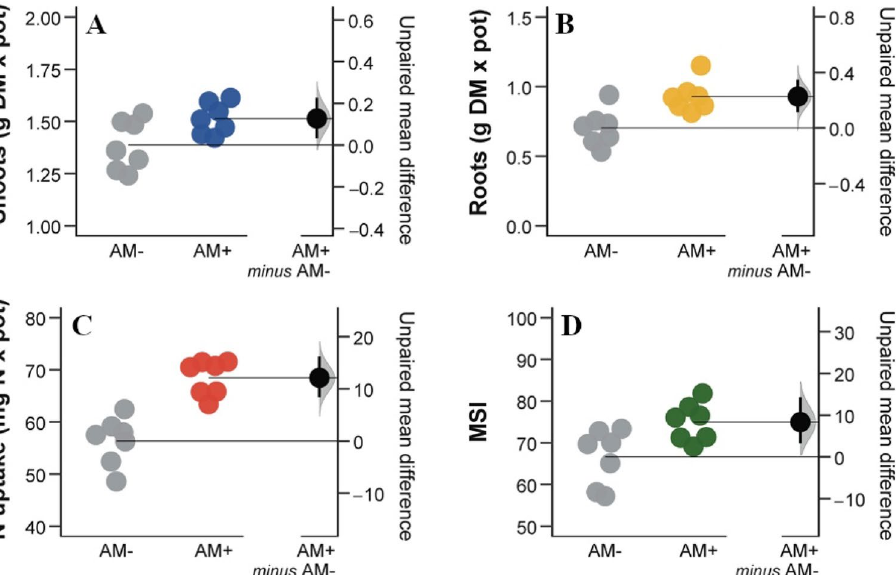
Figure 1. Shoot ( A ) and root ( B ) biomass, total N uptake ( C ) and membrane stability index (MSI; D ). Raw data of Control (AM−, grey dots) and arbuscular mycorrhizal treatment (AM+, coloured dots) are shown in the plot. The filled curve indicates the resampled distribution of unpaired mean difference for AM + minus AM−, given the observed data. Horizontally aligned with the mean of the test group (AM +), unpaired mean difference is indicated by the black circle. The 95% confidence intervals of each difference is illustrated by the black vertical lines.